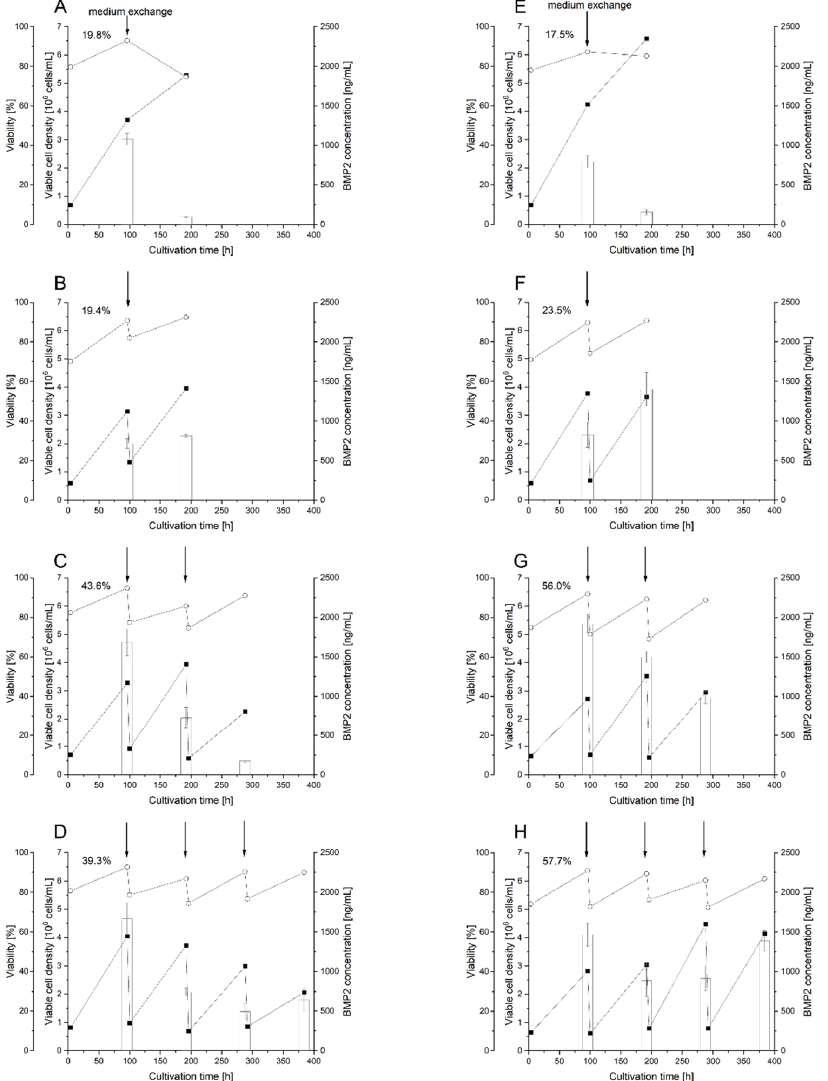
Figure 4. Micro-scale RTT production of BMP2 by HEK sus cells using pchBMP2 spiked with 1% ( w/w ) pEGFP-N1 in two independent biological replicates (n = 2) referred to as ( A – D , E – H ). The TE (% on the top left) is given as determined 48 h post initial transfection. Shown are the viable cell density ( ■ ) and viability ( ○ ). Arrows indicate the time points of the transfection repetition. The cell culture supernatant was collected at 96 h post transfection, and the BMP2 concentration (white bars) was measured by ELISA. For ( A , E ), a medium exchange was performed 96 h post transfection as indi- cated.